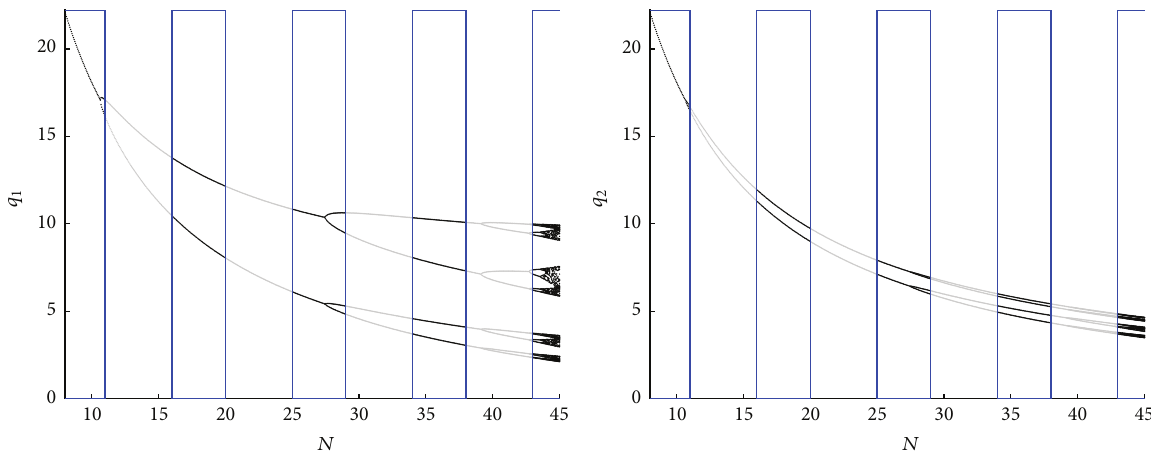
Figure 3: Bifurcation diagrams of quantities 𝑞 1 and 𝑞 2 with respect to the oligopoly size 𝑁 , for 𝑎 = 20 , 𝑏 = 0 . 1 and keeping fixed the oligopoly composition 𝜔 = 1 / 9. Increasing the oligopoly size has a destabilizing